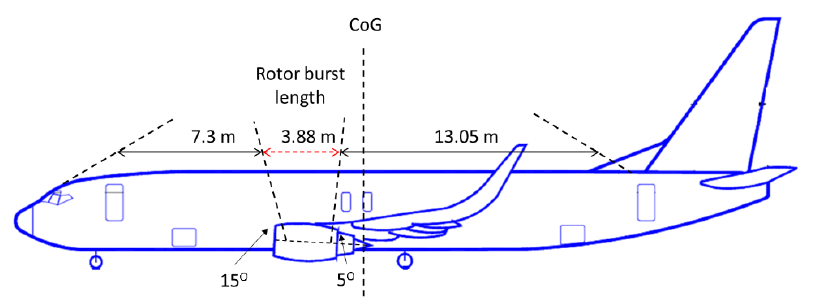
Figure 9. Schematic representation of the 737–800 type adopted from [44].